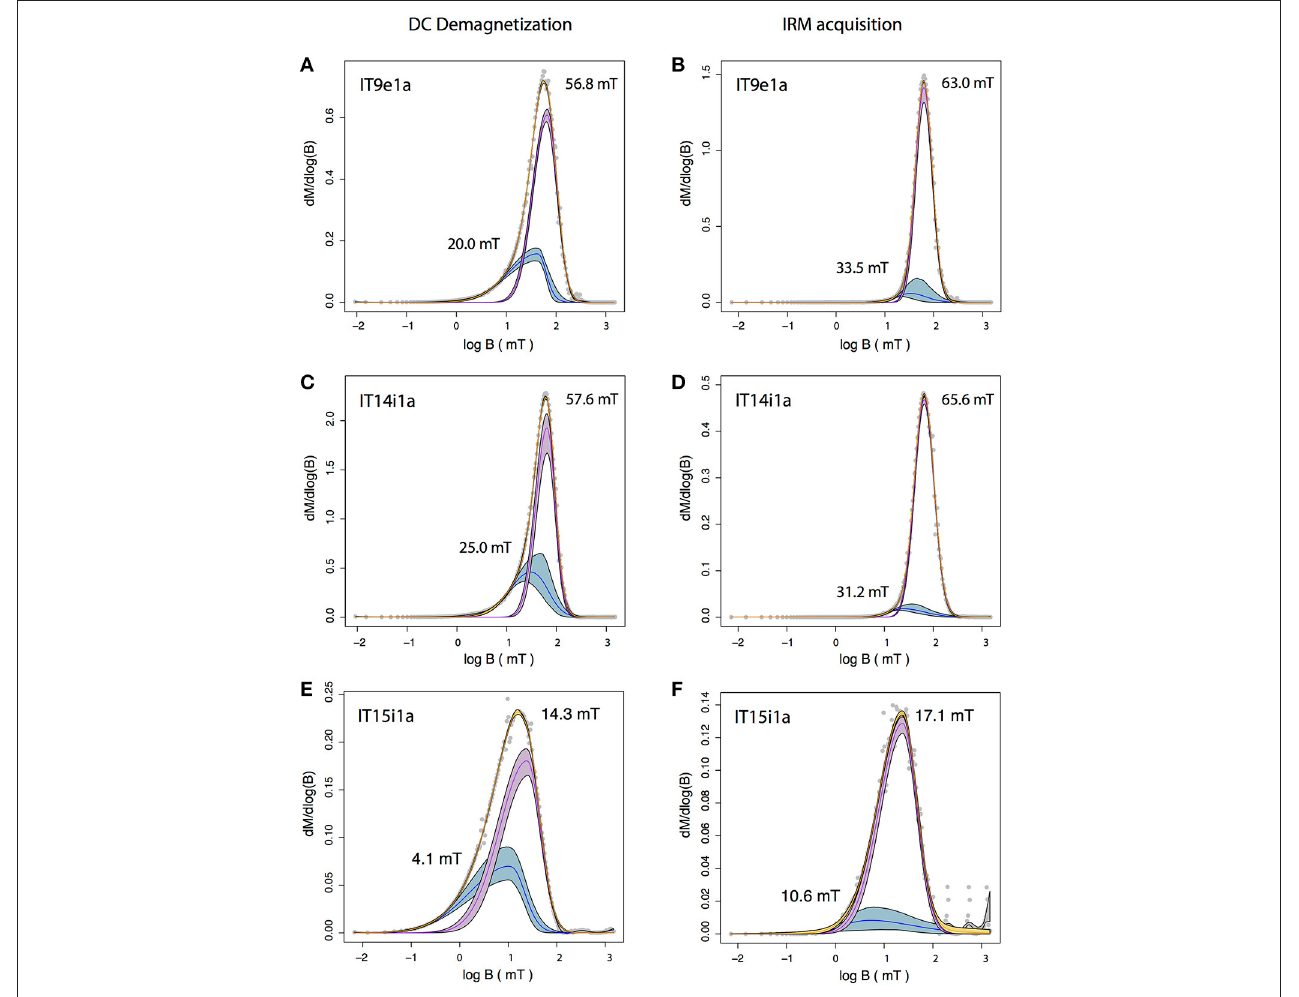
FIGURE 5 | Unmixing of backfield DC demagnetization and IRM acquisition curves: (A,B) specimen from sill at IT9; (C,D) specimen from sill at IT14; (E,F) specimen from sill at IT15. Note how the coercivity distributions are systematically revealed at lower fields during demagnetization than acquisition. See text for